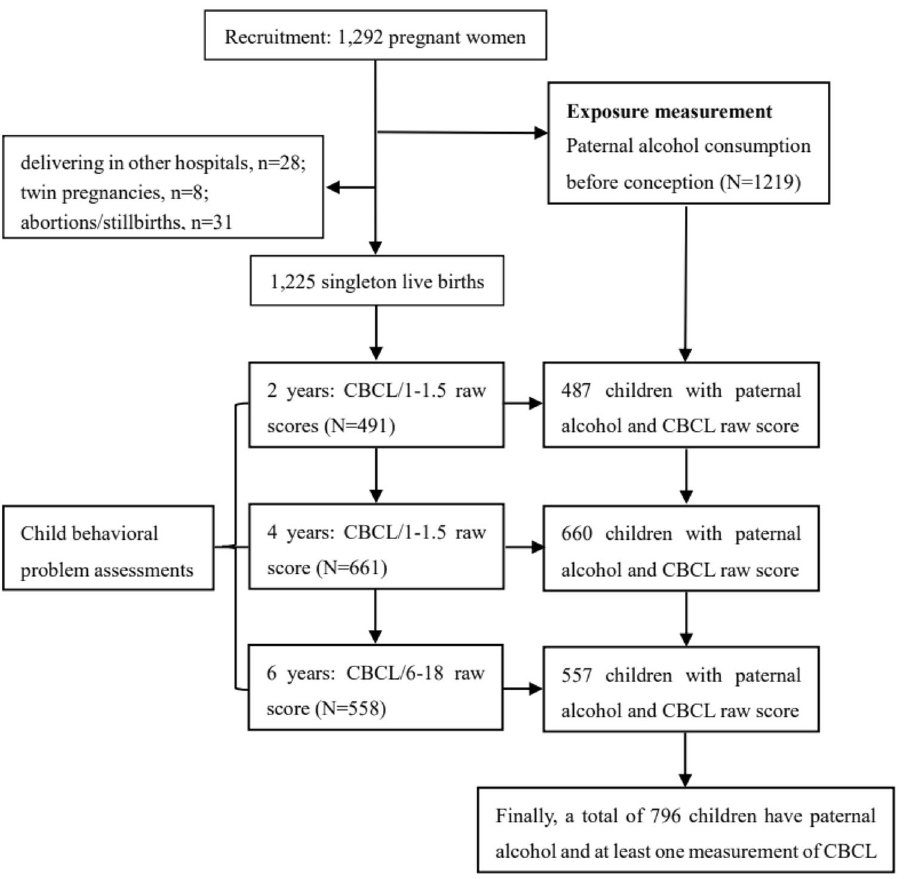
Figure 1. The flow chart depicting the selection procedure of study participants from the S-MBCS